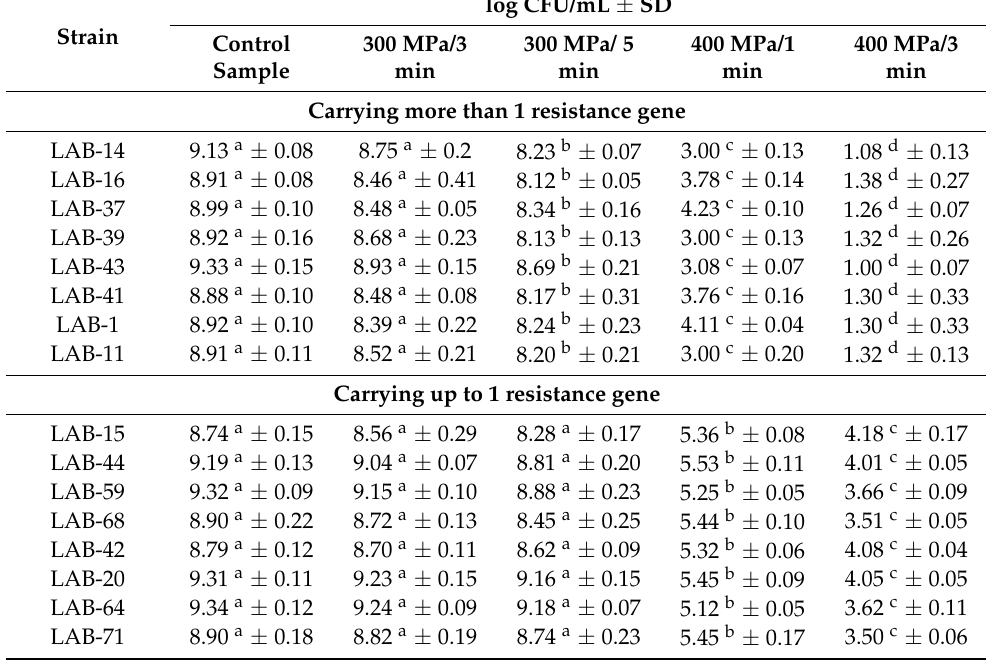
Table 2. Results of the survival analysis of strains in response to high-pressure treatment (mean values of log CFU/mL ±